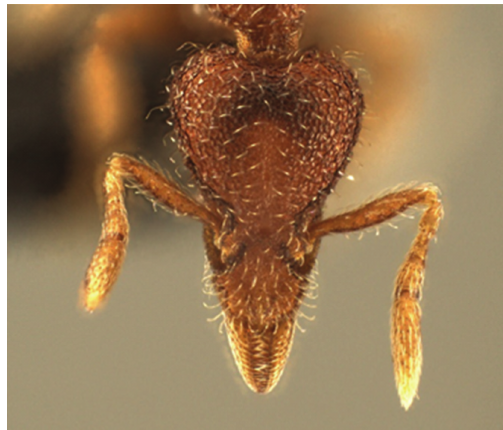
Figure 1: Pyramica ohioensis . Figure 2: Pyramica rostrata .